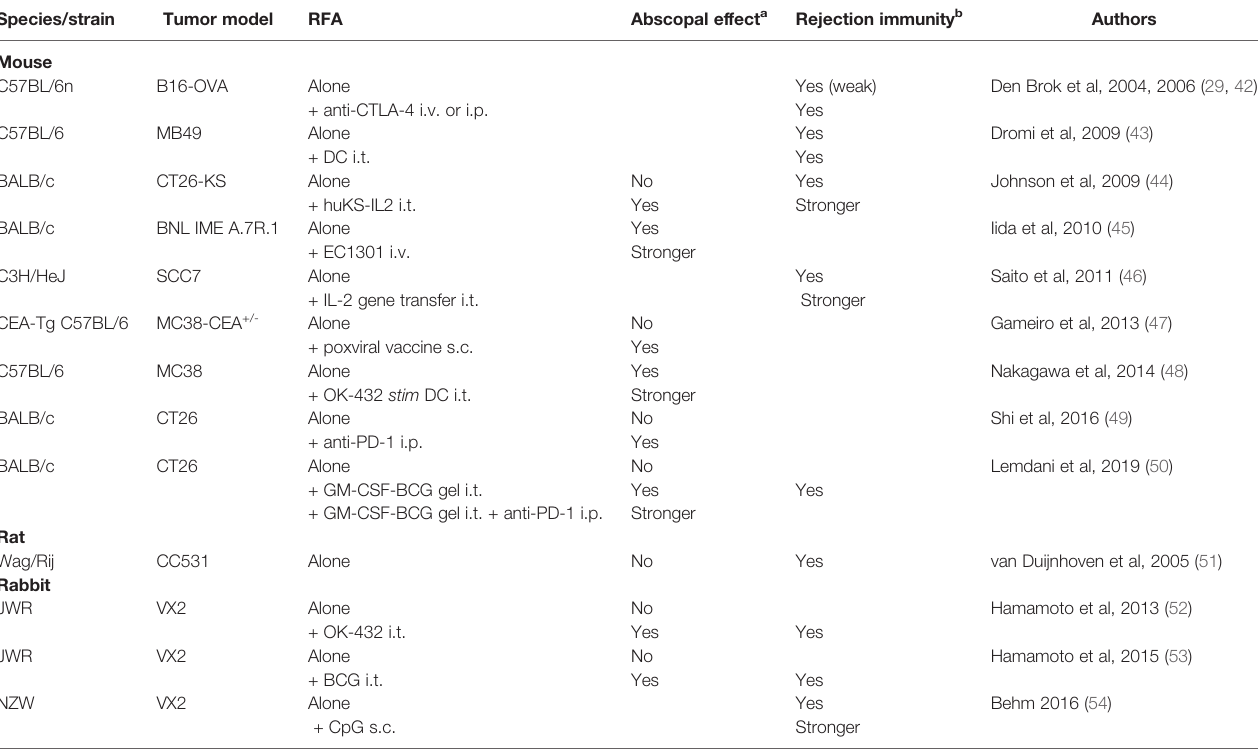
TABLE 1 | Effect on systemic disease after radiofrequency ablation (RFA) in animals.